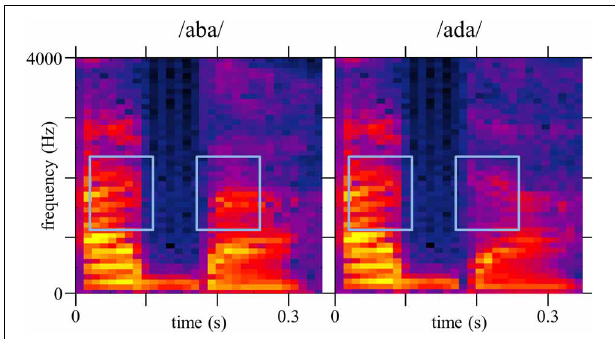
FIGURE 1 | Spectrograms of target-signals t 0 (/aba/) and t 1 (/ada/) used for the vectorized spectrograms T 0 and T 1, on a logarithmic scale (dB). Blue boxes indicate the second formantic transition